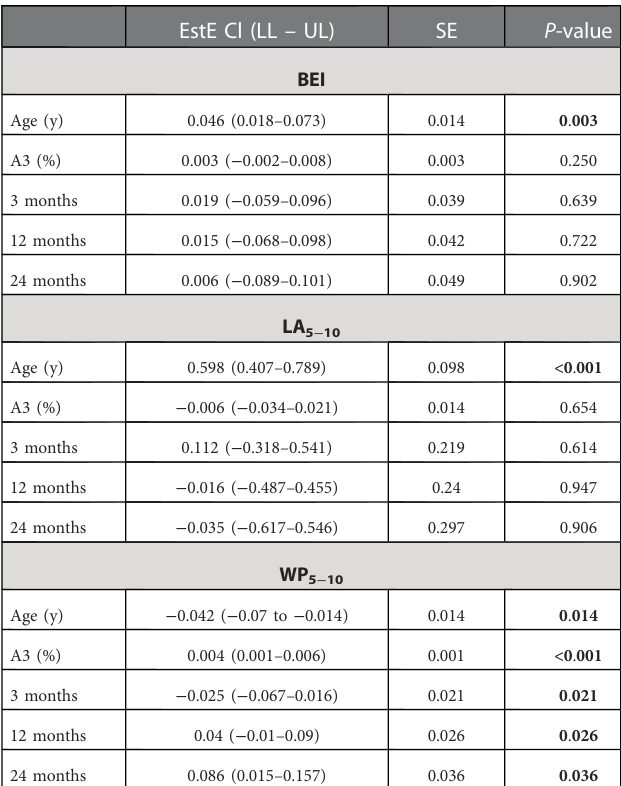
TABLE 4 Linear model to predict temporal development of airway parameters. Patient and lung regions are random effects. The fi xed effects were age, A3, and the examination time point (3 months, 12 months, and 24 months), and the endpoints were the airways parameters BE, LA 5 − 10 , and WP 5 − 10 . The regression coef fi cient (EstE) describes the in fl uence on the fi xed effect the change between one time point and the following time point. The con fi dence interval (Cl) with its lower and upper limits (LL – UL) and the standard error (SE) is also